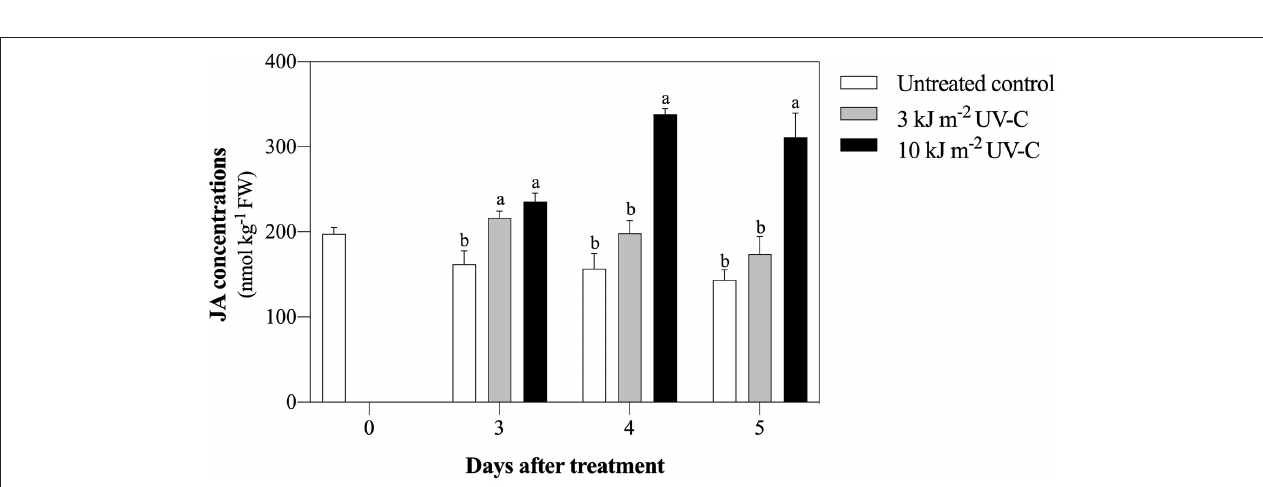
FIGURE 3 | Effect of UV-C treatment on change of malondialdehyde concentration in satsuma mandarin fruit in untreated control, 3 kJ m − 2 , and 10 kJ m − 2 UV-C groups. The different letters indicate significant differences at P ≤ 0.05 by LSD test at each day with the mean ± SE of three replications.